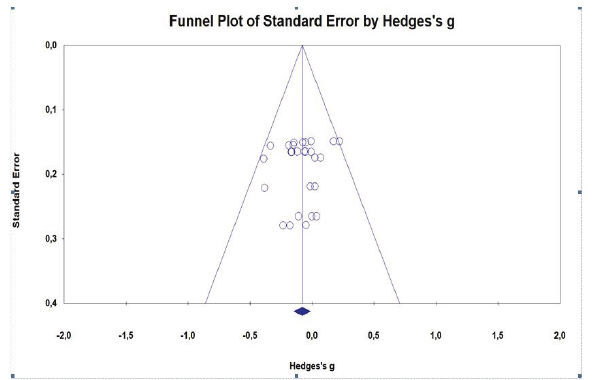
Figure 2 - Funnel plot of effect